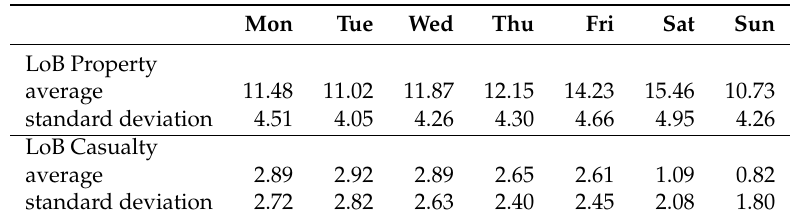
Table 1. Statistics per weekday: average daily claims counts and empirical standard deviation for LoB Property and LoB Casualty.